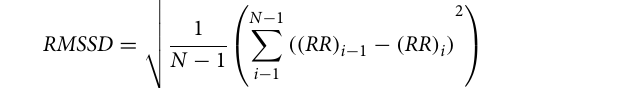
sleep 10–12,28 as well as human American Association of Sleep Medicine 2018 guidelines 29 . Heart rate. Heart rate (HR) and inter-beat intervals (between R peaks of the heart beat signal: (R-R)) were recorded using a Polar equine monitoring girth strap with electrodes near the heart and the reference electrode near the shoulder (Fig. 3) and logged with the Polar RS800CX Watch (Polar Electro Oy, Kempele, Finland). The time was synchronized between the watch and PSG recording devices. Ultrasound gel (Aquasonic 100 gel, Parker Laboratories, NJ, USA) was applied liberally at electrode locations. Data were downloaded using Polar Pro-Trainer 5 software (Polar Electro Oy, Finland). After downloading, the signal was filtered using Polar Pro- trainer 5 at a moderate filter power with a minimum protection zone of 6 bpm. Only traces containing less than 1% identified errors were used for analysis. The filtered data were then extracted, and statistics were calculated in 30 s epochs corresponding to the timestamps of the PSG epochs. Only the time domain metrics of the heart rate variability were calculated, as the validity of frequency domain metrics in intervals smaller than the 5 min standard are questionable 38 .